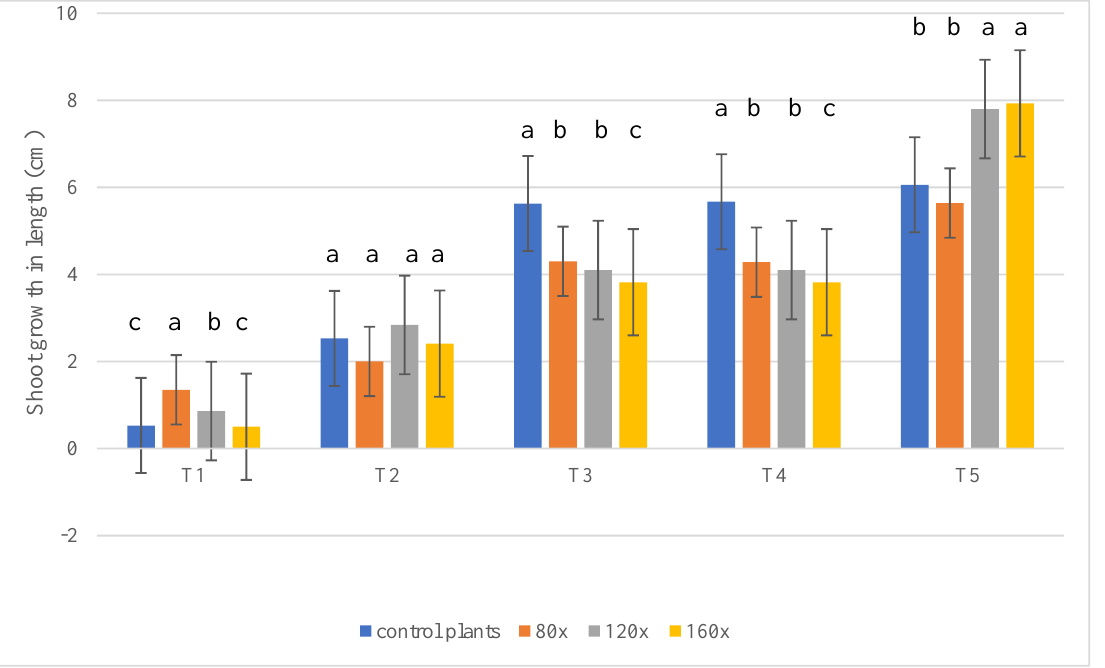
Figure 1. Shoot growth in petunia subjected to MS depending on stress intensity. Statistical analysis was made in each term separately. A total of 15 plants in each block from each treatment were measured in each of the five terms (α − 0.05). The lowercase letters p resent statistical differences (α − 0.05) between the treatments.